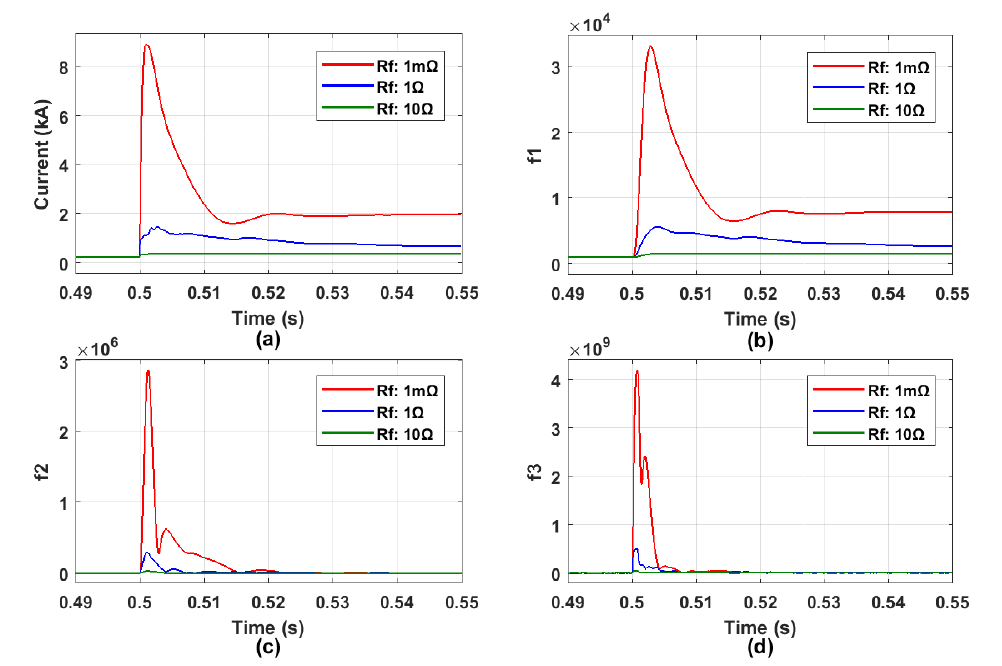
Figure 7. Pole-to-pole fault currents and their feature comparisons with fault resistances of 1 m Ω , 1 Ω , and 10 Ω at F1, ( a ) actual current, ( b ) feature f 1 , ( c ) feature f 2 , ( d ) feature f 3